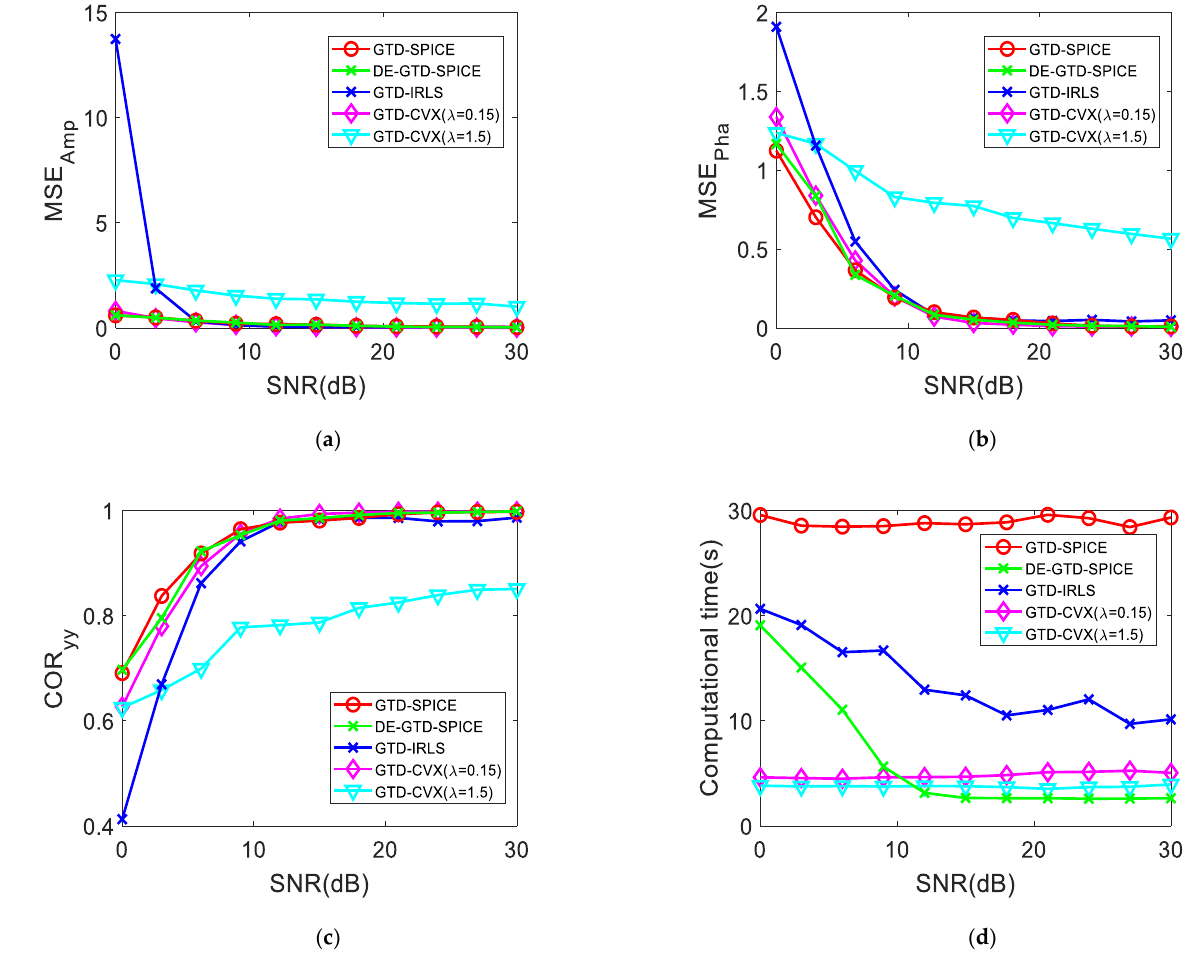
Figure 8. Comparison on ( a ) MSE of the amplitude of the reconstructed RCS sequence, ( b ) MSE of the phase of the reconstructed RCS sequence, and ( c ) the correlation coefficient versus the SNR. ( d ) Computational time versus the SNR.